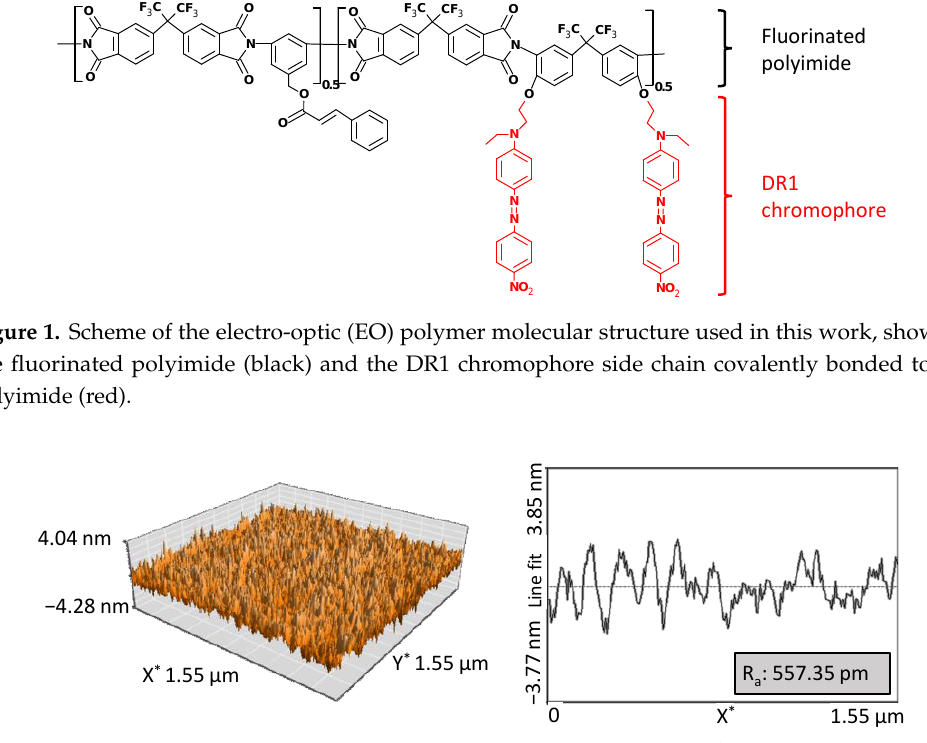
Figure 1. Scheme of the electro-optic (EO) polymer molecular structure used in this work, showing the fluorinated polyimide (black) and the DR1 chromophore side chain covalently bonded to the polyimide (red).